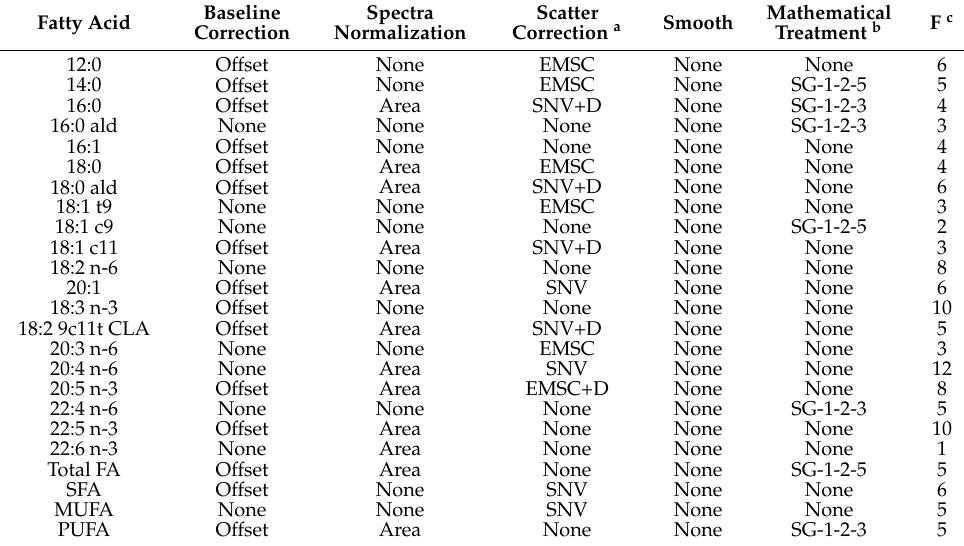
Table 3. Spectral treatments and factors included in the prediction models of phospholipid fraction of fatty acids of beef. Fatty Acid